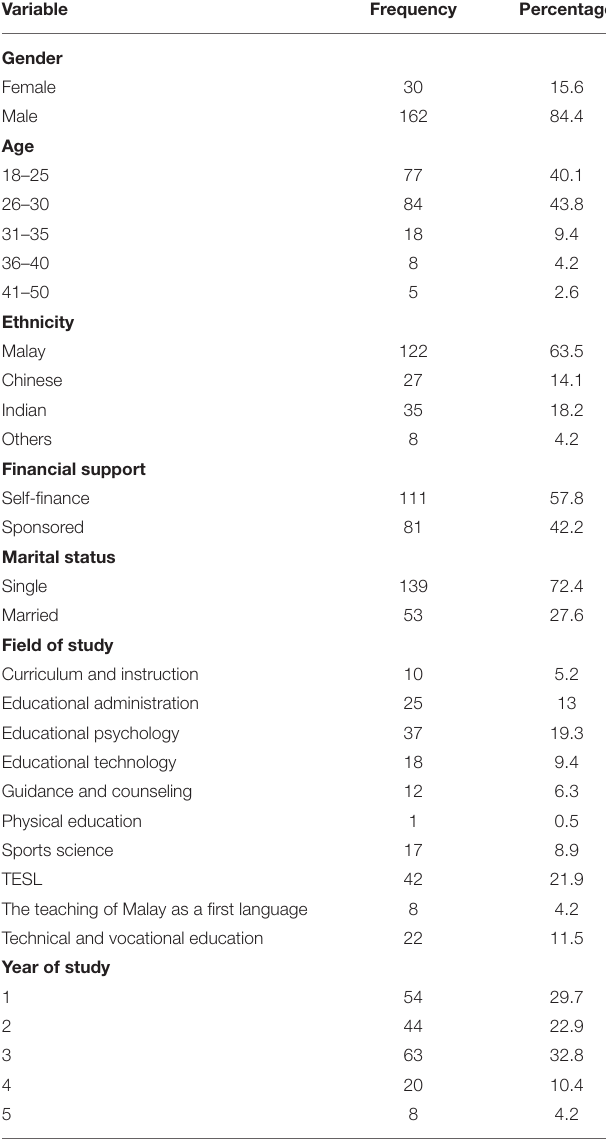
TABLE 1 | Demographic characteristics of the